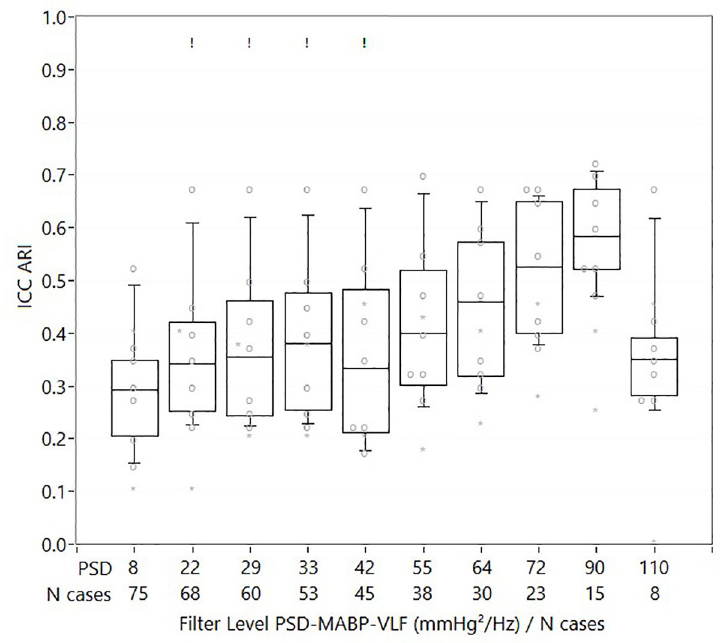
Fig 5. ICC values for ARI and correlation like indices. Beeswarm boxplot with ICC values for ARI and correlation like indices for different cut-off levels of PSD-MABP. Each grey dot represents an analysis method. ! : indicates cut-off level at which significant differences between the methods were found. � indicates correlation like indices, which were not included in calculation of the boxplot. The increase in ICC with increasing cut-off levels was significant for ARI like indices, when the highest cut-off level (110) was